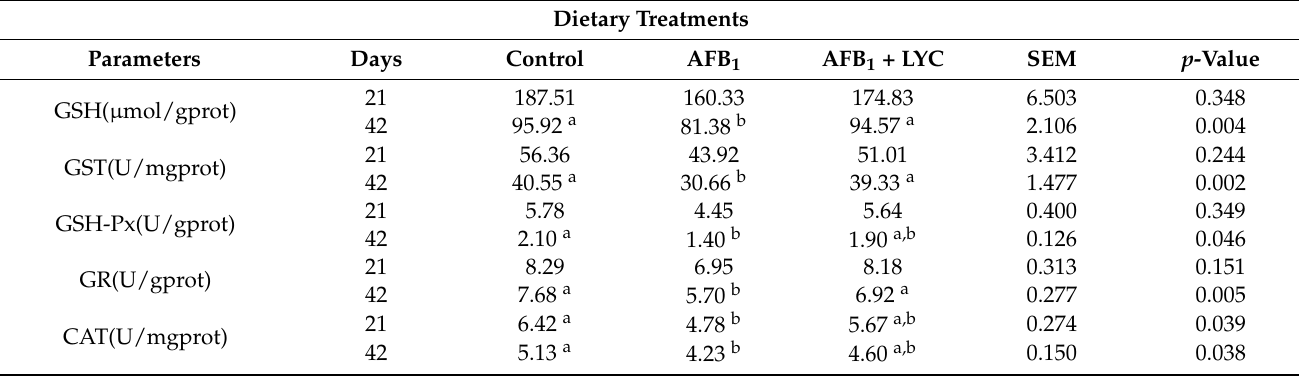
Table 5. Effects of LYC on antioxidant index in the jejunum of broilers fed with AFB 1 contaminated diets at 21 and 42 days. Dietary